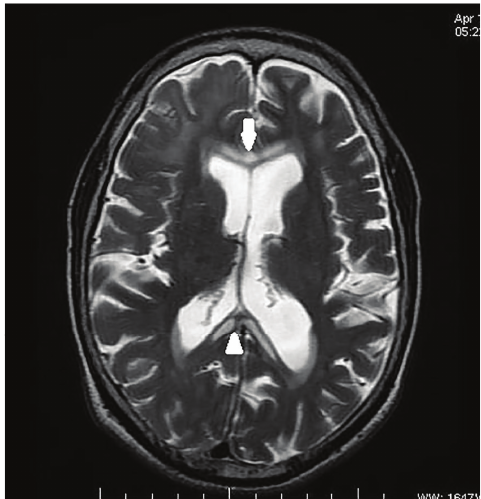
Figure 2: Axial T2 weighted image showing hyperintensity of genu (white arrow) and splenium (white arrowhead) of corpus callosum.